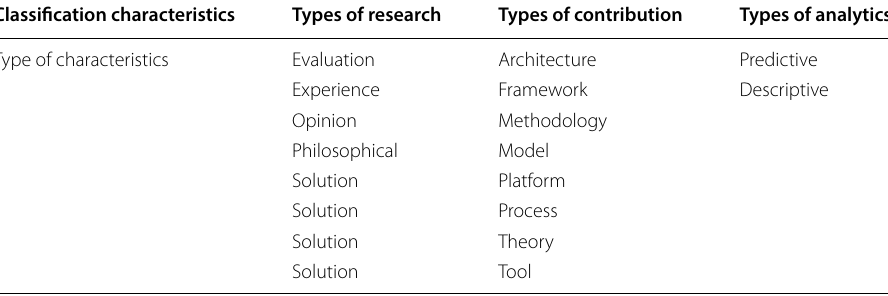
Table 3 Publications classification characteristics Classification